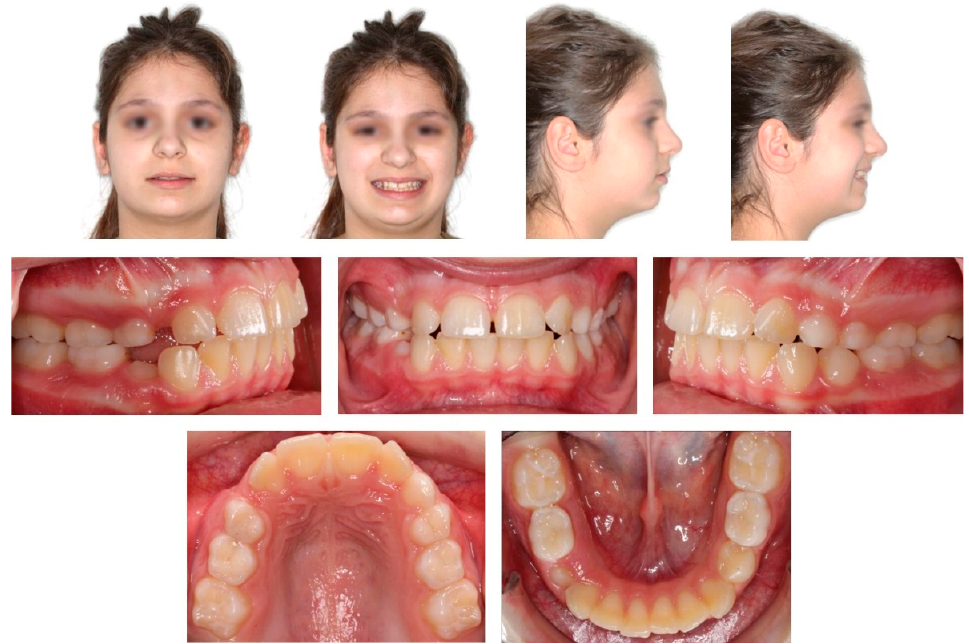
Figure 1. Pre-treatment extra- and intra-oral photographs.